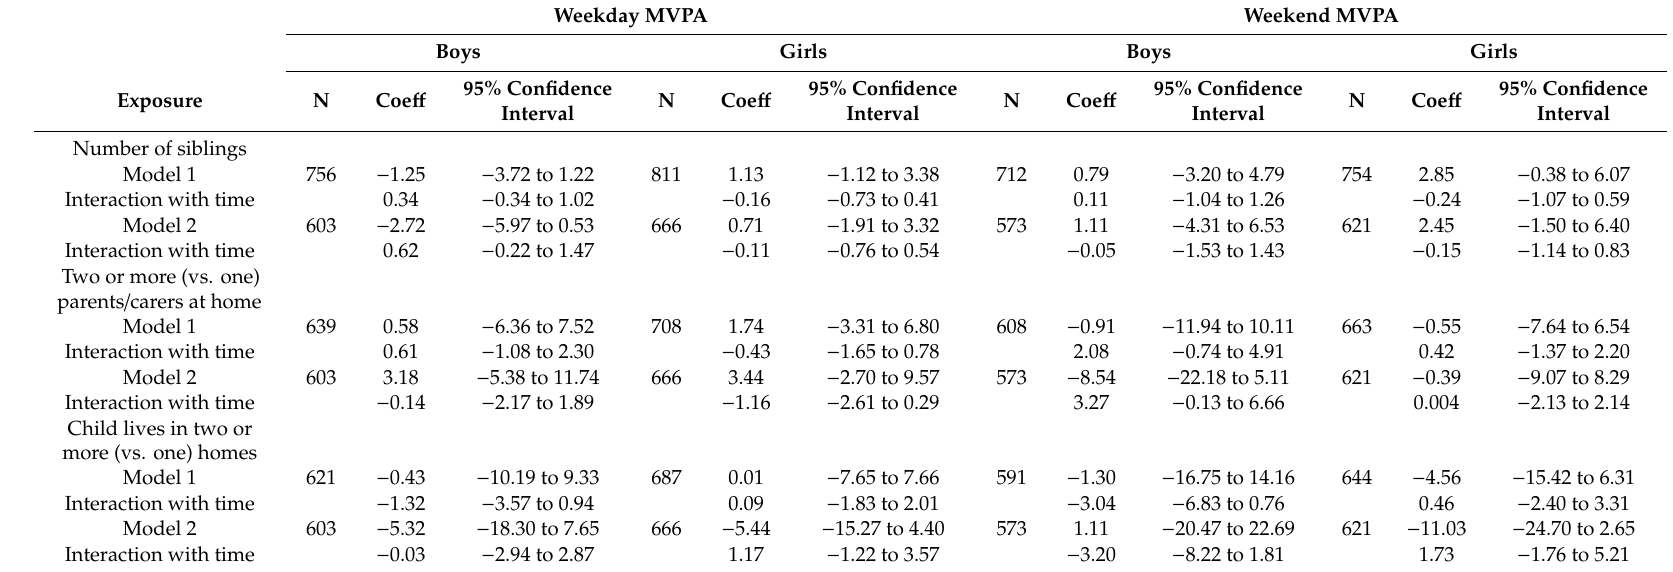
Table 5. Longitudinal associations of weekday MVPA with change in family structure variables between age 6 and 11. Weekday MVPA Weekend MVPA Boys Girls Boys